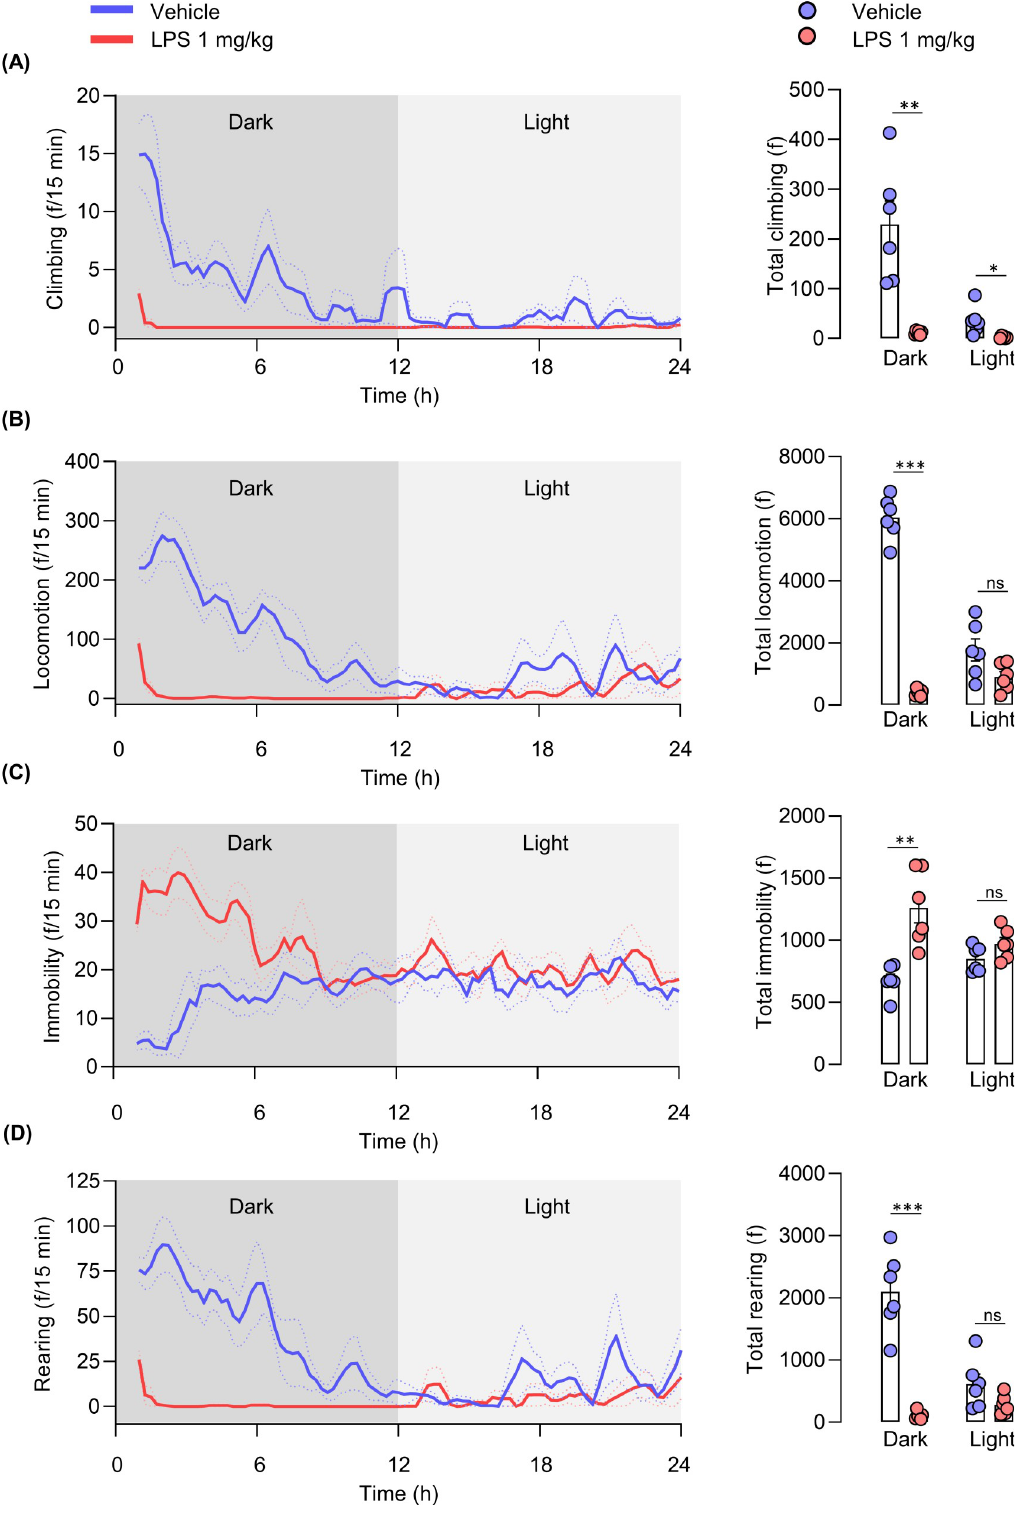
Fig 8. Frequency of home-cage behaviors of LPS-induced mice throughout a 24 h period (dark and light phases). Each line depicts the moving average of each behavior for both control and LPS groups. (A) Climbing, (B) locomotion, (C) immobility, (D) rearing. Unpaired t-test, N = 6 mice per group; � p < 0.05, �� p < 0.01, ��� p < 0.001 compared with the control group.